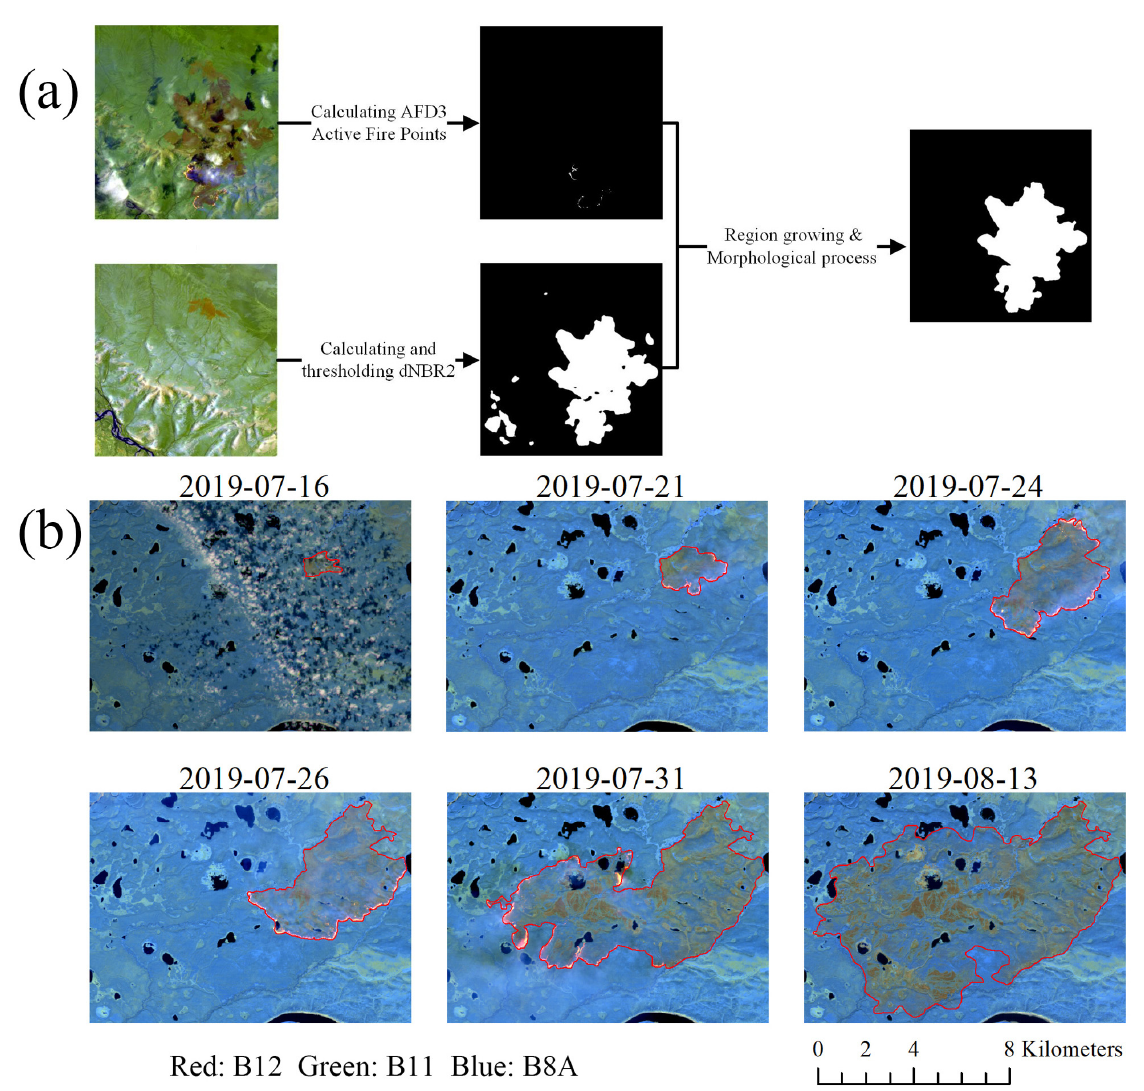
Figure 4. Tracking fires. ( a ) Schematic flow chart of burnt land entities extraction. Top row is an active fire image, while bottom row the corresponding image before ignition. ( b ) Tracking of a single fire, as shown by the red polygon. Bands 8a, 11, and 12 of the Sentinel-2 L2A product were used to extract the perimeters of the burnt land automatically.